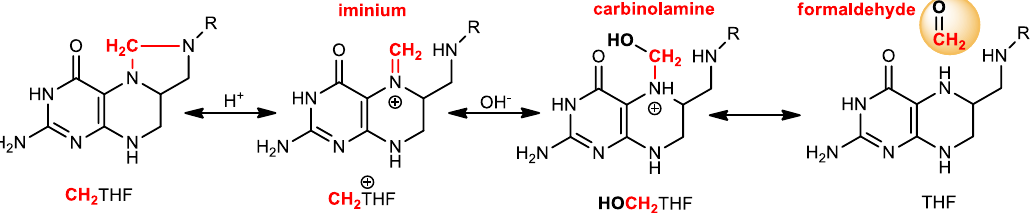
Fig. 1 Hydrolysis reaction of N 5 ,N 10 -methylenetetrahydrofolate as a source of formaldehyde. The cyclic form of CH 2 THF is activated by protonation leading to the iminium species (CH 2 THF + ). This iminium is potentially in equilibrium with its carbinolamine counterpart (HOCH 2 THF). The carbinolamine intermediate can readily decompose into THF and formaldehyde (CH 2 O) in a reversible reaction 28 . CH 2 O can then serve as a direct source of